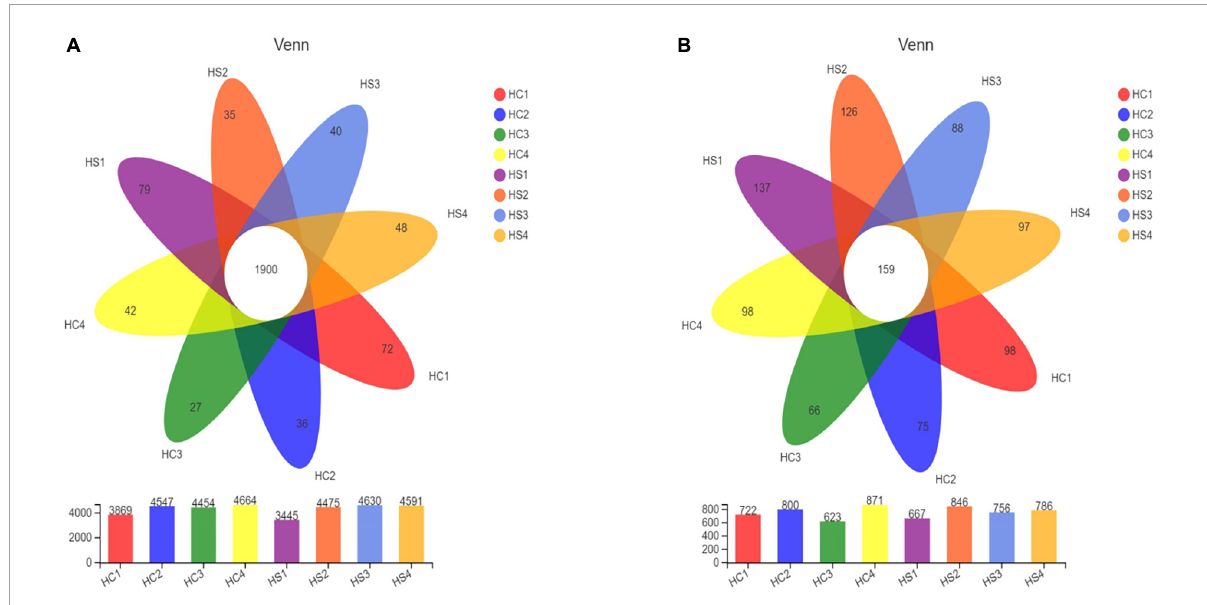
FIGURE2 Venn analysis shows common and endemic species among soil samples [panel (A) for bacteria, panel (B) for